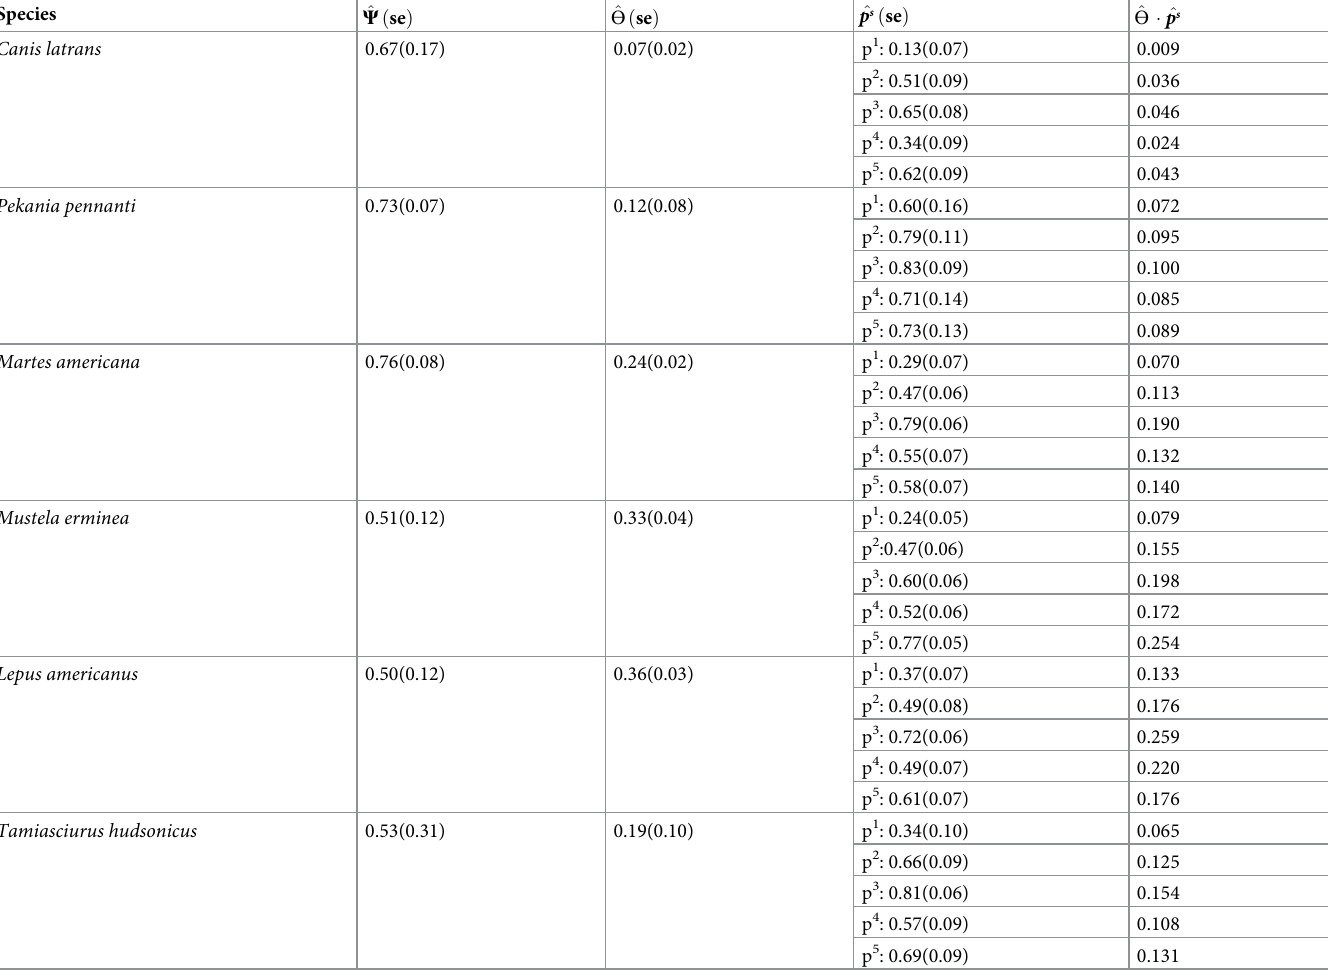
Table 3. Parameter estimates for six mammal species in Maine: ^ Ψ is the probability of occupancy, ^ ϴ is the probability of availability for detection on any survey day, and ^ p is the probability of detection with a specific method conditional on availability. Species ^ Ψ ð se Þ ^ ϴ ð se Þ ^ p s ð se Þ ^ ϴ � ^ p s Canis latrans